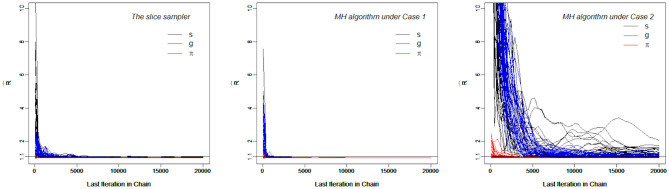
The trace Plots of R^ for the slice-within-Gibbs sampler and MH algorithms in Simulation Study 2.